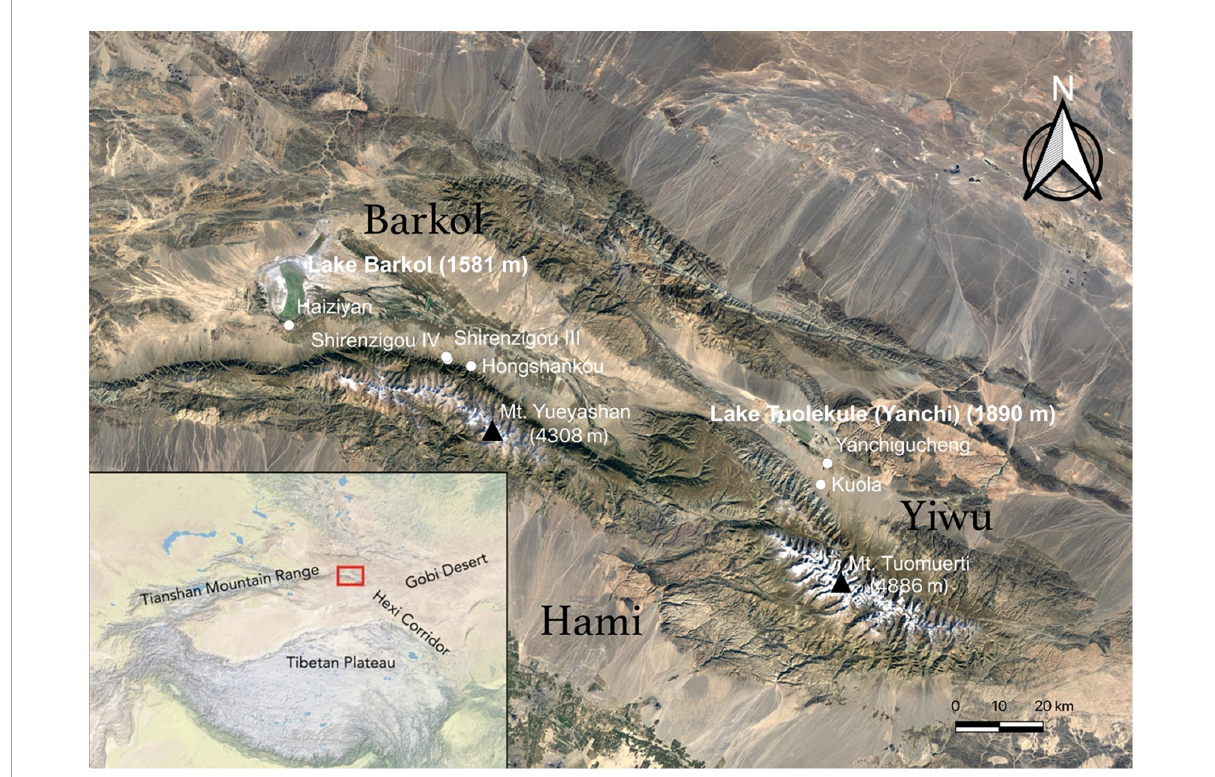
FIGURE7 The locations of Shirenzigou IV (SRZ IV, 2,140 m.a.s.l.), Shirenzigou III (SRZ III, 2,200 m.a.s.l.), Haiziyan (HZY, 1,600 m.a.s.l.), Yanchigucheng (YCGC, 2,020 m.a.s.l.), Kuola (KL, 2,200 m.a.s.l.) and Hongshankou (HSK, 2,200 m.a.s.l.) in the eastern Tianshan region. The lowest and highest elevations of Barkol are at Lake Barkol (1,581 m.a.s.l.) and Yueyashan (4,308 m.a.s.l.), respectively. The lowest and highest elevations of Yiwu are at Lake Tuolekule (1,890 m.a.s.l.) and Tuomuerti (4,886 m.a.s.l.), respectively. Maps were generated using ArcMap v. 10.2 with data credit to National Park Service Natural Earth physical map (public